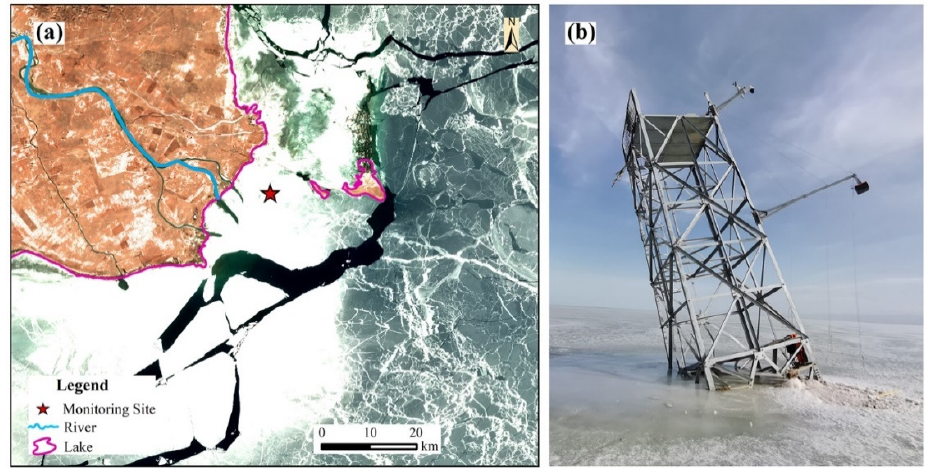
Figure 11. Distribution of melting ice (in black color) near GPR ice monitoring system (in pentacle) in Sentinel 2A MSI image acquired on 26 March 2021 ( a ) and photo of the tilted tower on 27 March 2021 ( b ).